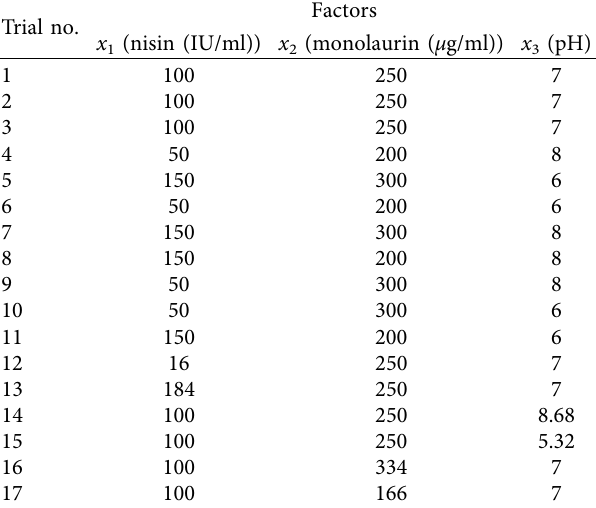
Table 1: Experimental design for the central composite design. Trial no.